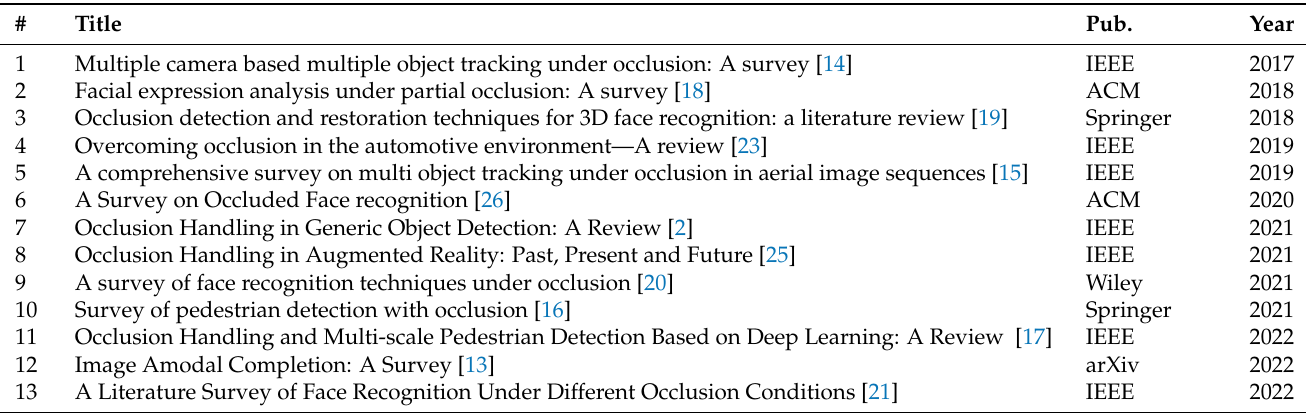
Table 1. Existing survey articles about occlusion that were published between 2017 and